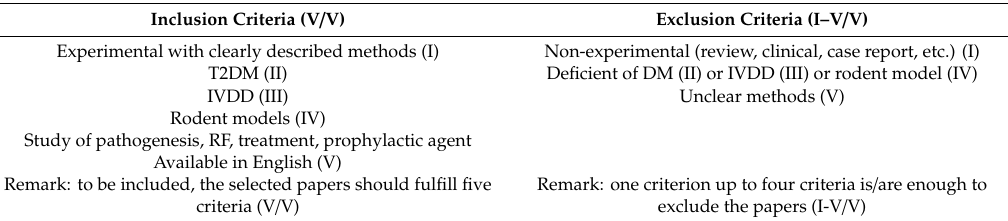
Table 3. Inclusion and exclusion